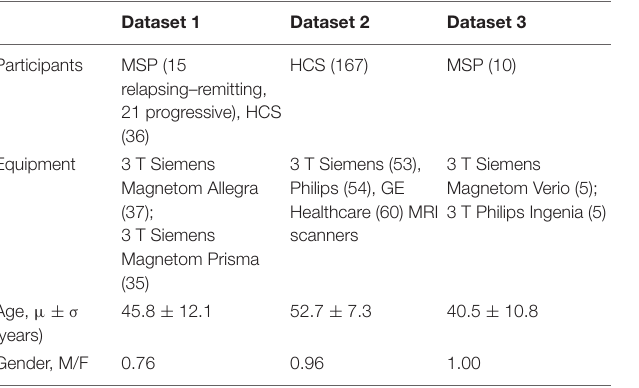
TABLE 3 | Dataset summary details for the included participants.